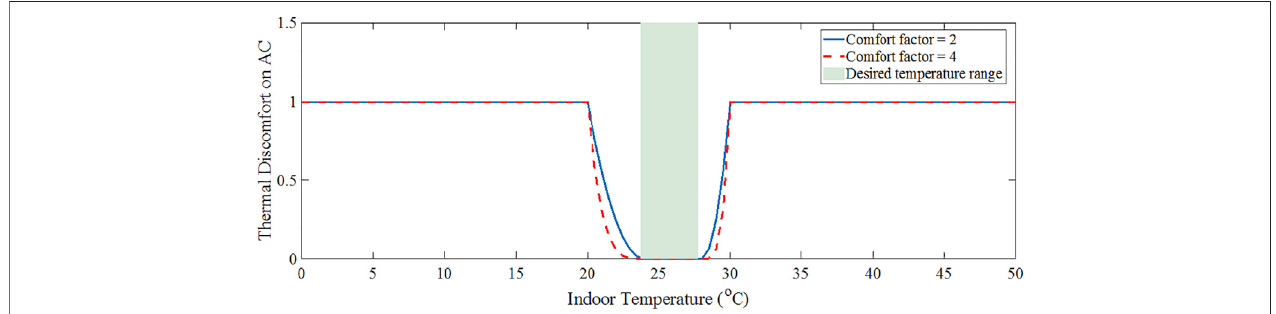
FIGURE 6 | Illustration of the variation of the occupant ’ s discomfort degree on the AC ’ s operation ( T dsr , low (cid:2) 24, T dsr , up (cid:2) 28, T set , low (cid:2) 20, T set , up (cid:2) 30).